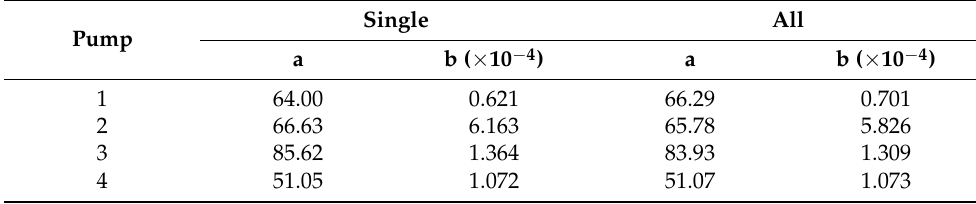
Figure 8. Estimated pumps curves for the test case pumping station. Table 1. Pumps’ curve